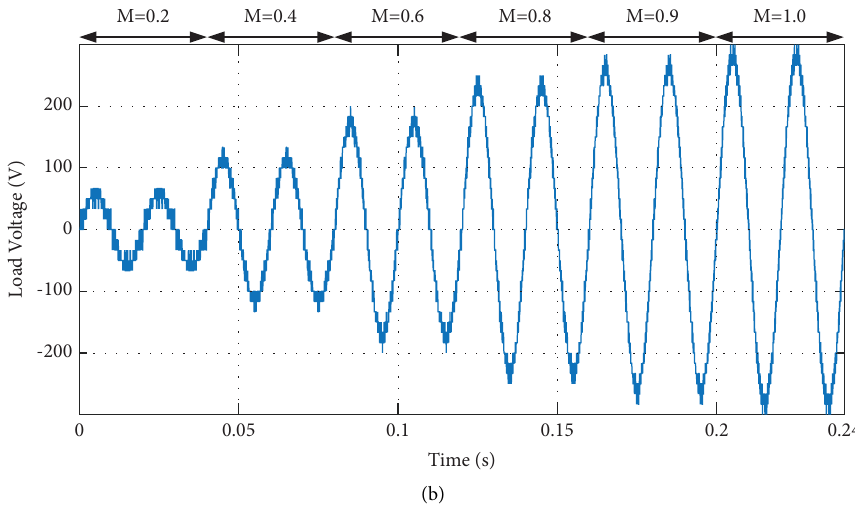
Figure 14: 11L CHB inverter load voltage for dynamic values of M . (a) SVPWM-I. (b) SVPWM-II.